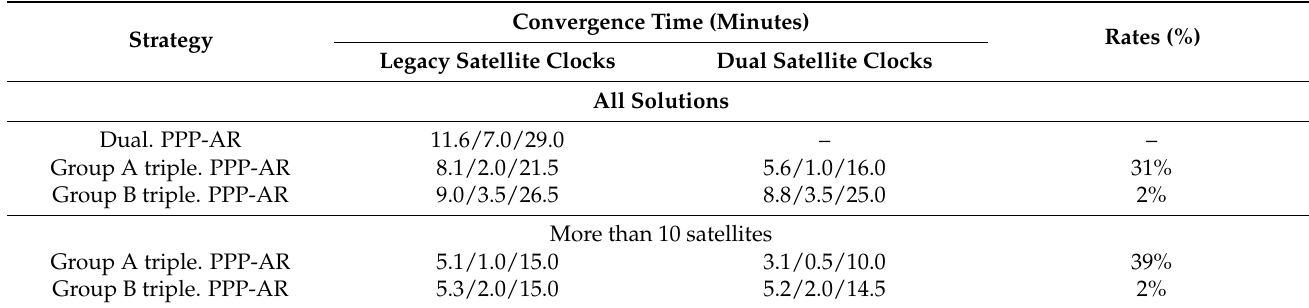
Table 5. Convergence times of PPP-AR over all solutions. Mean, 50th, and 90th percentiles are given, delimited by two slashes. The fourth column is the improvement of solutions using dual clocks compared with dual-frequency counterparts. Strategy